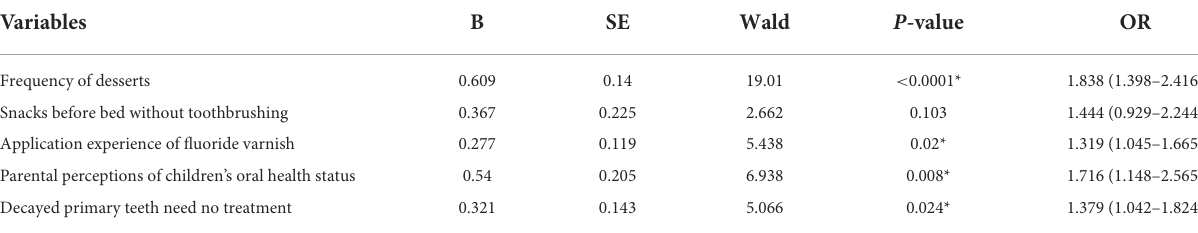
TABLE 4 Logistic regression analysis of factors associated with the prevalence of dental caries in first permanent